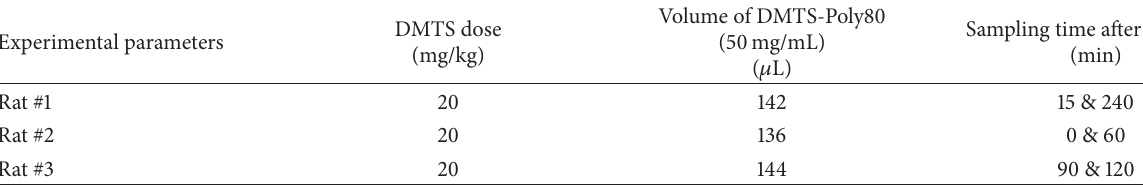
Table 1: Experimental parameters for the DMTS intravascular residence time study.